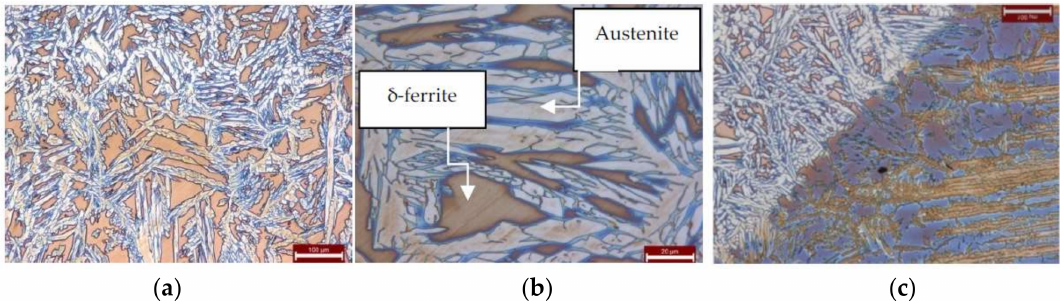
Figure 6. Micrographs of weldments joined by Ar + 3% N 2 shielding gas ( a ) weld metal 100 × ( b ) weld metal 500 × ( c ) HAZ 100 × .